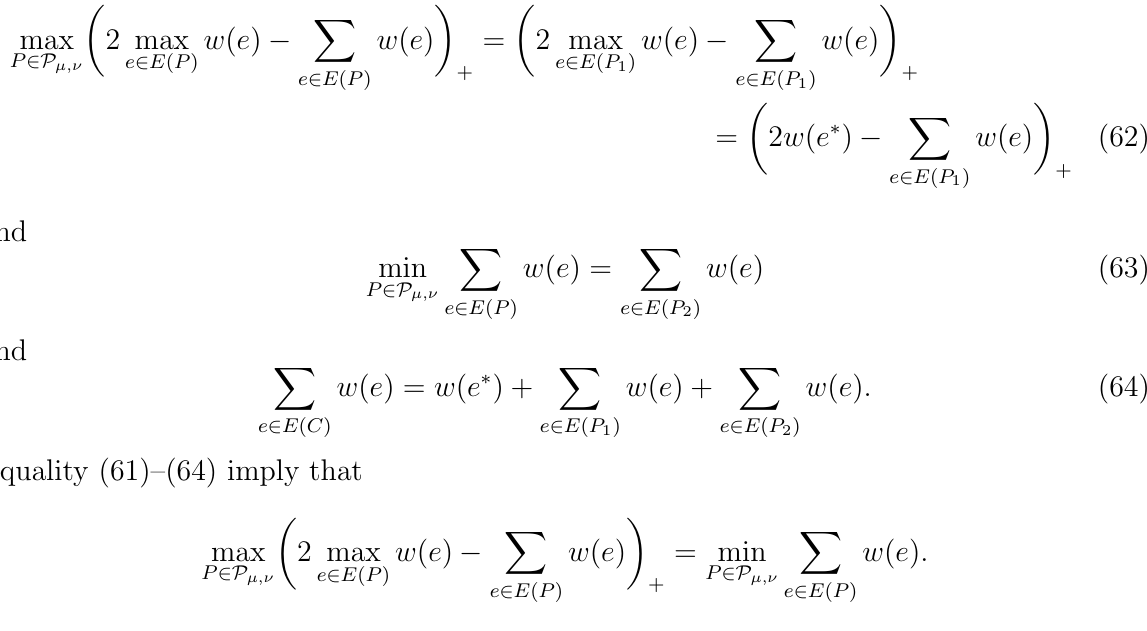
= ν are non 4 = ( v , v , v , v 2 4 5 6 7